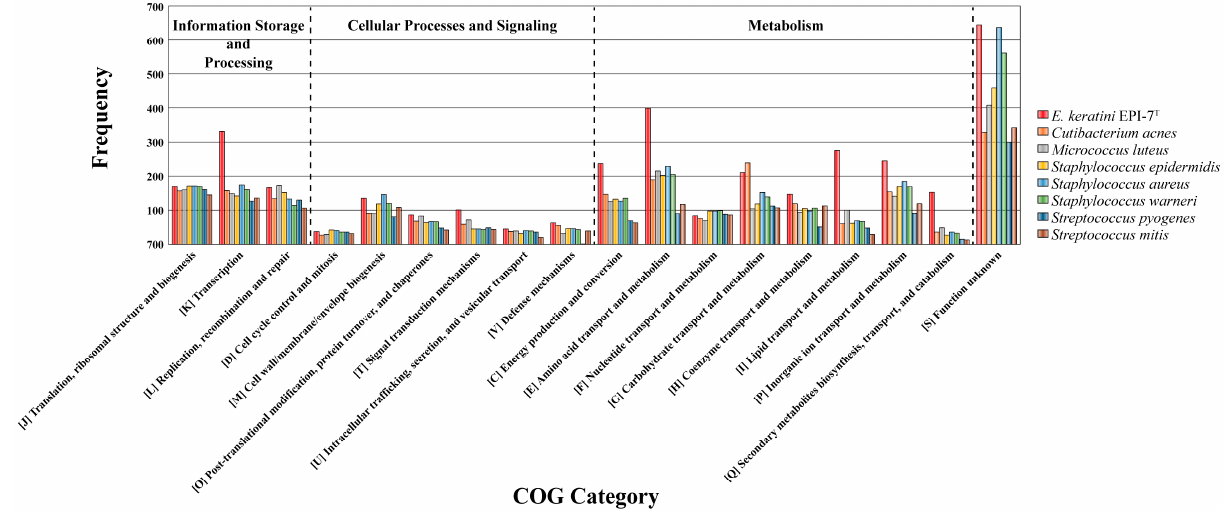
Figure 7. Bar chart plot showing the frequency of genes per COG category. EggNOG-mapper based on COG category frequency showed that E. keratini EPI-7 T contained significantly more genes related to the metabolism category than other strains.